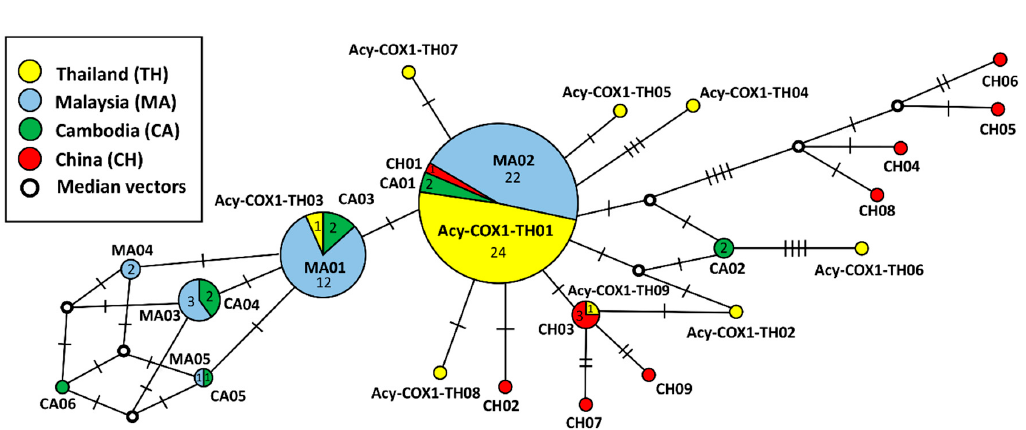
Figure 3. The haplotype network map of A. ceylanicum based on a fragment of the cox1 gene from Thailand, Cambodia, China, and Malaysia. Circle size is scaled to frequencies of each haplotype. The hash marks indicate nucleotide substitutions among adjacent haplotypes. Table 3. Summary of the genetic diversity of the 4 populations of A. ceylanicum based on the nucleotide sequences of the partial mitochondrial cox1 gene. N